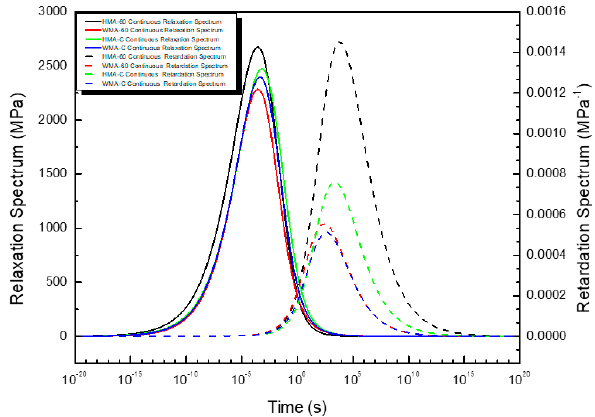
Figure 6 The Continuous relaxation spectrum and retardation spectrum of asphalt mixture Figure 6. The Continuous relaxation spectrum and retardation spectrum of asphalt mixture.